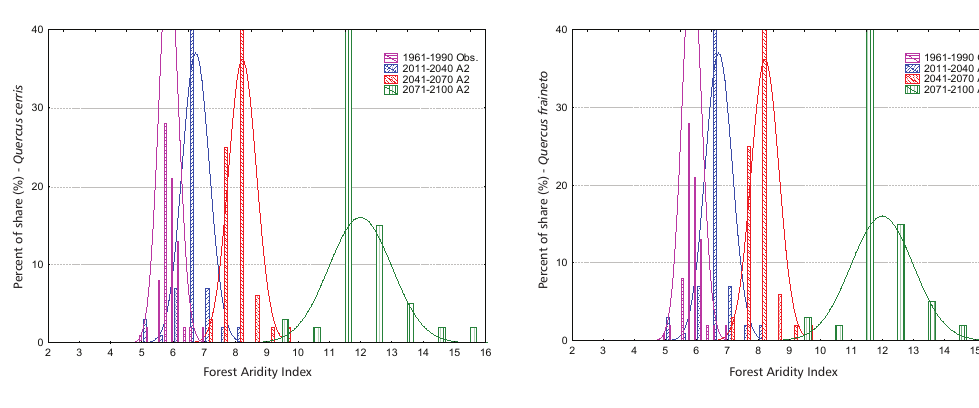
FIGURE 5. Distribution of Hungarian oak across FAI categories in four climate periods